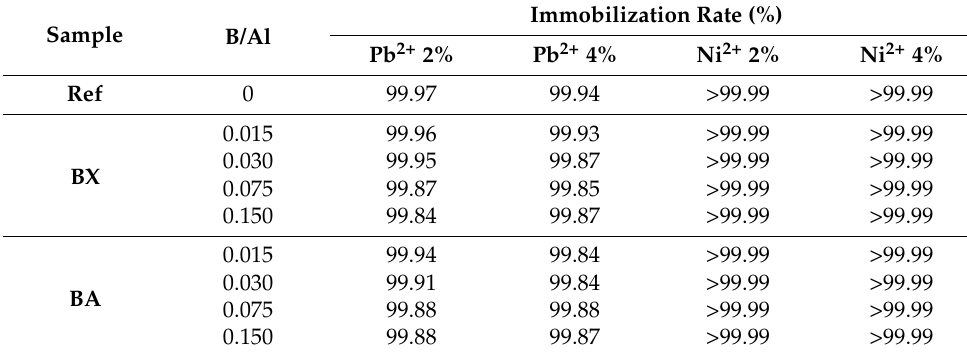
Table 3. Heavy metal immobilization in the geopolymers.